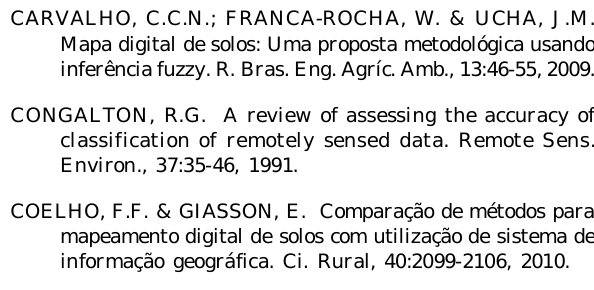
Table 1. Kappa coefficient indicating the degree of agreement among the maps created from three data sets of this study and the training map